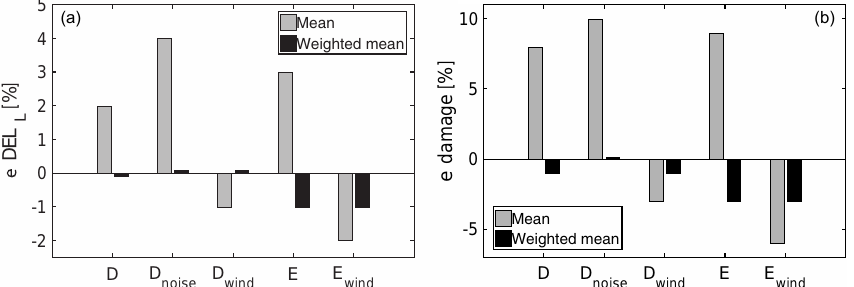
Figure 6. Results for M-DELs with 15 neighbors in five test cases: design basis D , design with artificial measurement noise D noise , design basis with wind speed binning D wind , extended simulations E , and extended simulations with wind speed binning E wind . The neighbors are taken as mean (grey) or weighted mean (black). (a) Percentage errors between predicted and calculated values of lifetime M-DELs. (b) Percentage errors between predicted and calculated values of lifetime